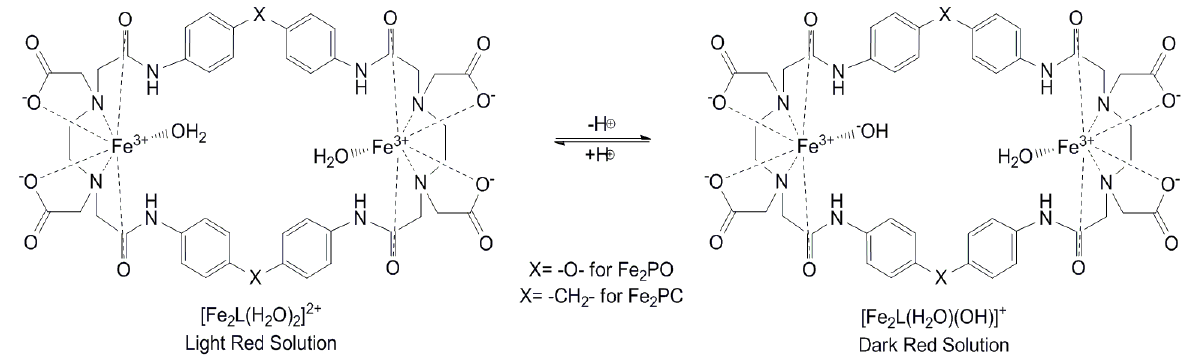
Figure 6. Changes in protonation state of the aqueous solutions of Fe complexes in dependence of